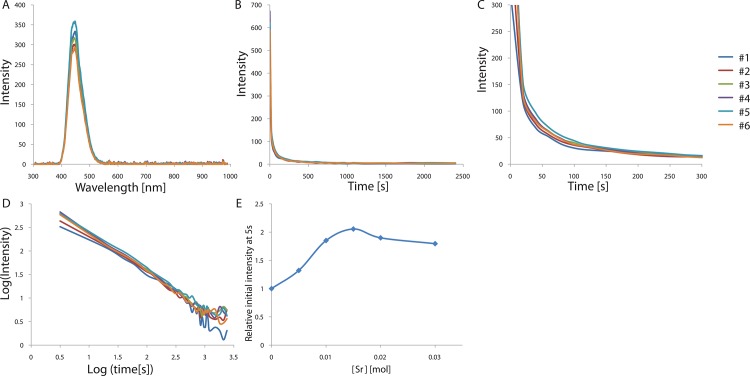
(A) Emission spectrum of CaAl2O4:Eu2+, Nd3+ crystals curves depending on Sr2+ concentration. (B) Decay curves depending on Sr2+ concentration. (C) Magnified views of the graph in (B). (D) Decay curves in log scale depending on Sr2+ concentration. (E) Relative initial intensity measured at 5s (relative values where the value of control sample #1 is 1.0) depending on Sr2+ concentration.